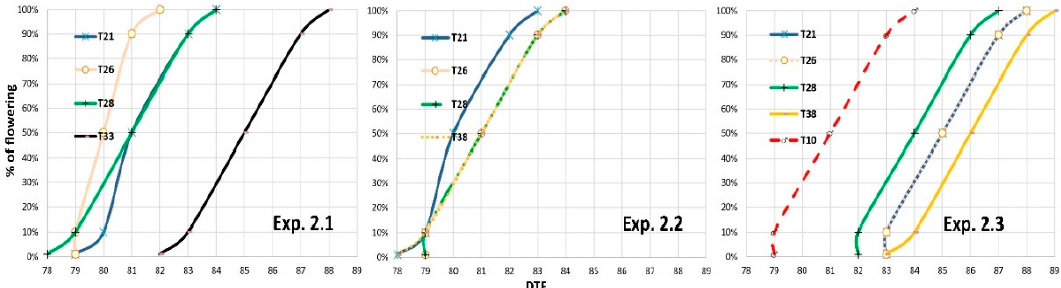
Figure 3. Average days to flowering (DTF) of lines T21, T26, T28, T33 and T38 (females) and T10 (male) in Exps. 2.1, 2.2 and 2.3.